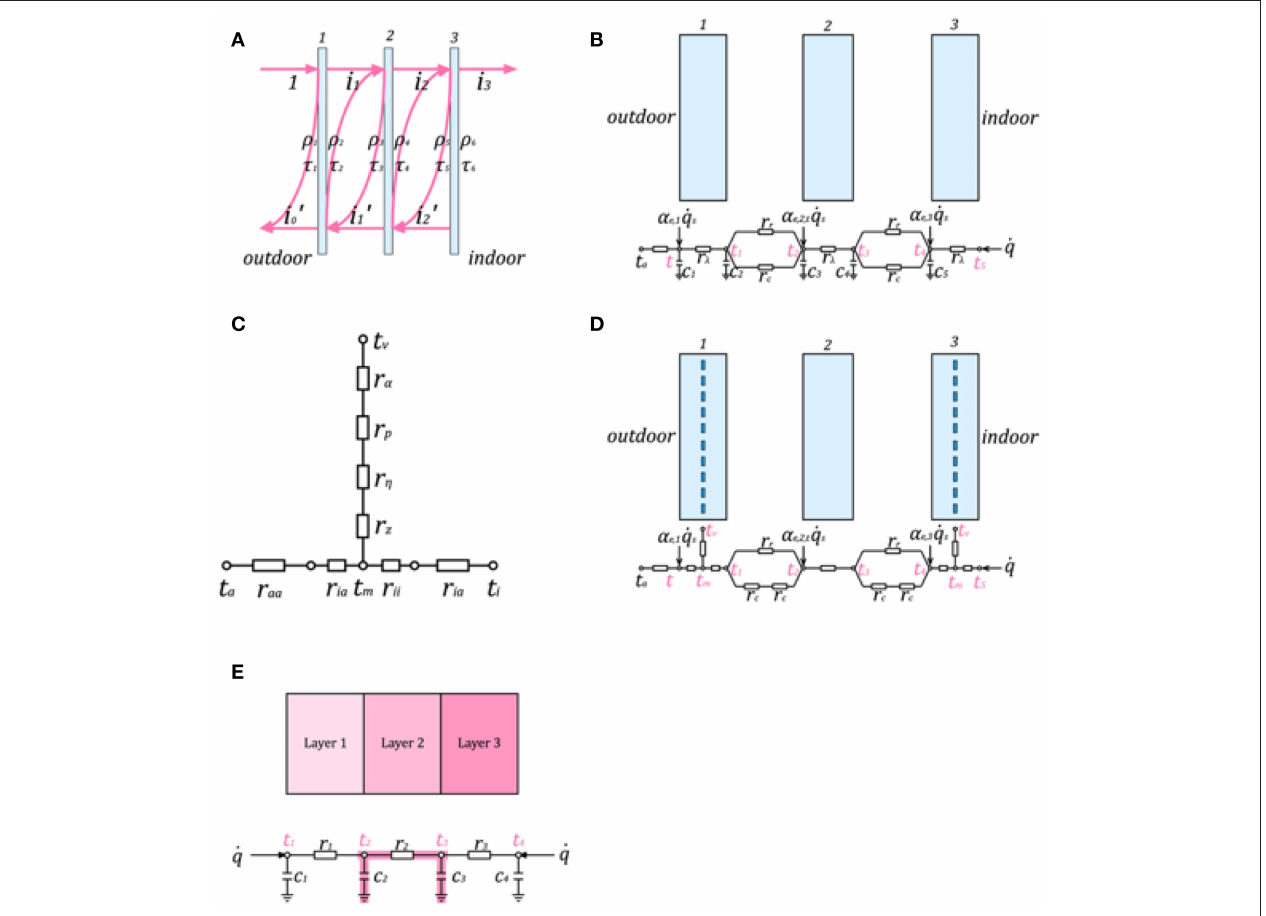
FIGURE 4 | (A) Optical model of triple-glazing IGU according to ISO 9050 (ISO, 2003) and VDI 6007 part 2 (VDI, 2012). (B) Electrical analogy of the window thermal model (see text for details). (C) R-model for thermo-active building component. (D) R-network applied to a thermal window model according to design option C in Figure 2 . (E) Beuken-Model for a 3-layer wall